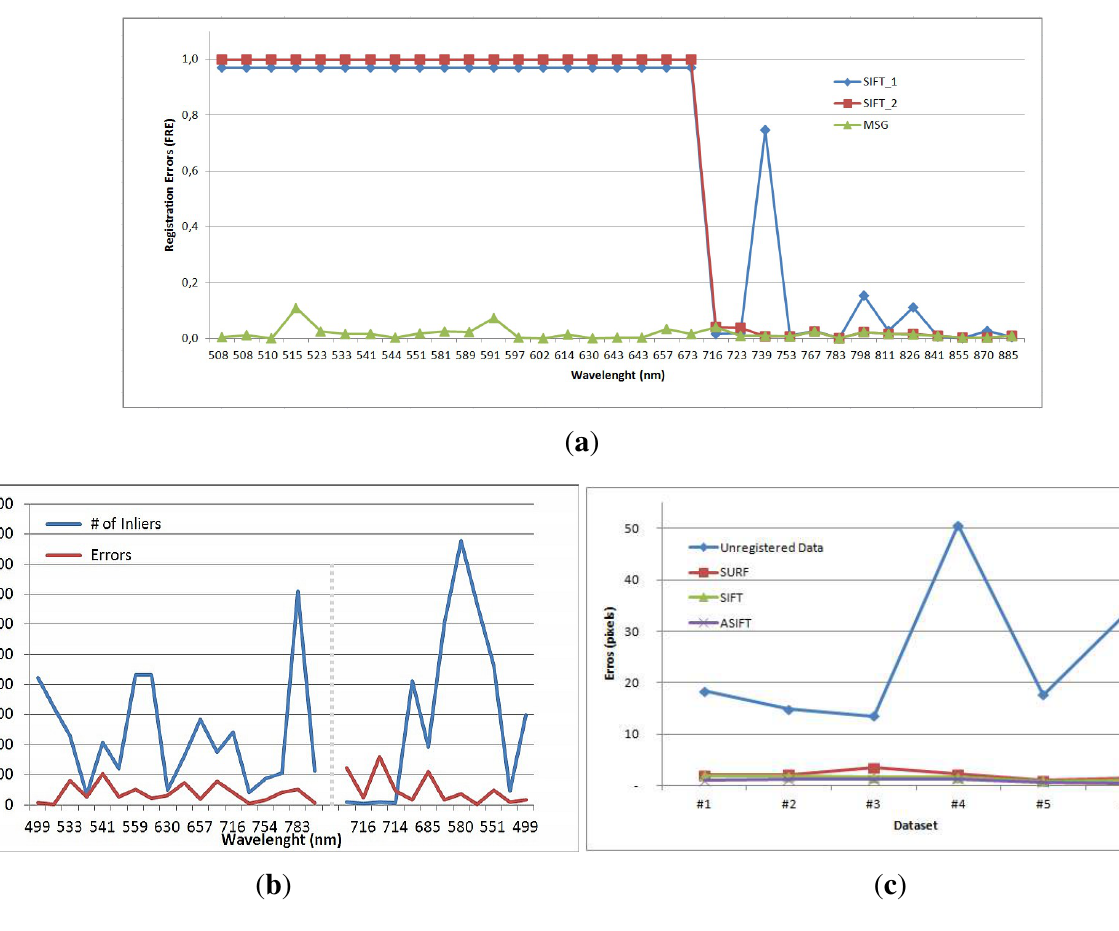
Figure 5. Quantitative Evaluation: ( a ) Errors for SIFT 2 (standard), SIFT 1 (more sensitive) and the developed (MSG-based) method for the dataset shown in Figure 1 ( b ) Number of inliers and registration errors (upscaled by a factor of 1000) at certain wavelengths; ( c ) Mean displacements (error in pixels) before and after the automated registration